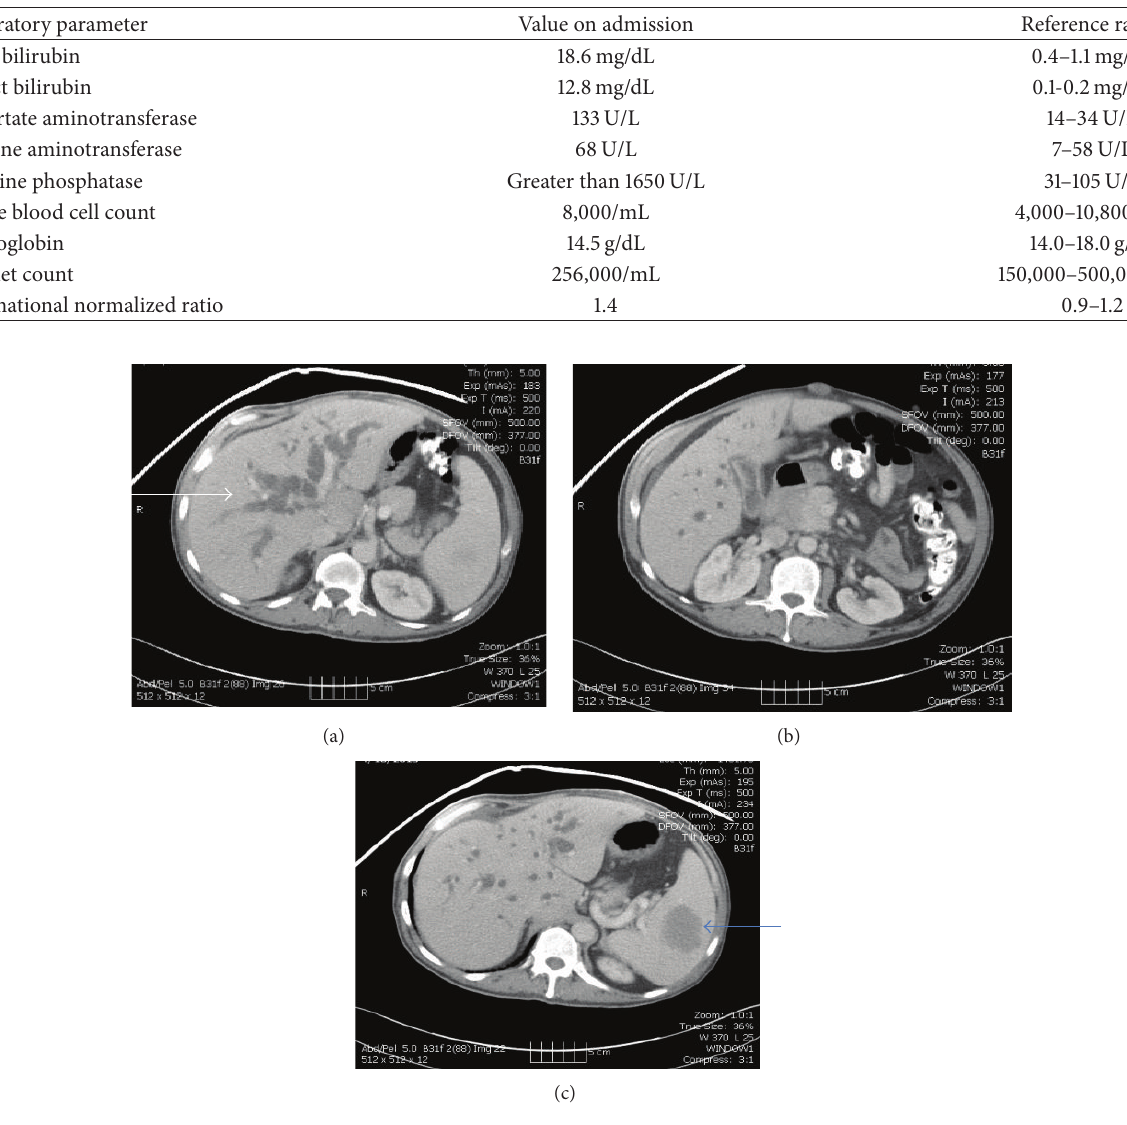
Figure 1: Computed tomography scans of the abdomen showed the porta hepatis mass, markedly dilated intrahepatic bile duct (white arrow), a 5cm splenic mass (blue arrow), and a retroperitoneal